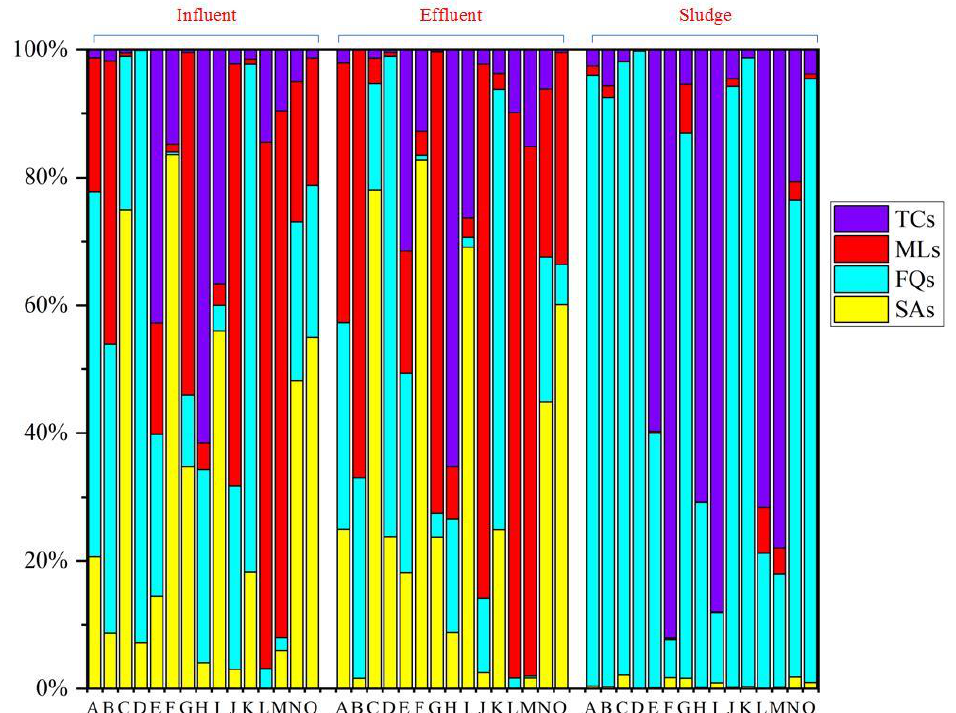
Figure 2. Composition profiles of different antibiotics in influent, effluent, and excess sludge from 15 pharmaceutical plants of China (Abbreviations: SAs: sulfonamides; FQs: fluoroquinolones; MLs: macrolides; and TCs: tetracyclines).